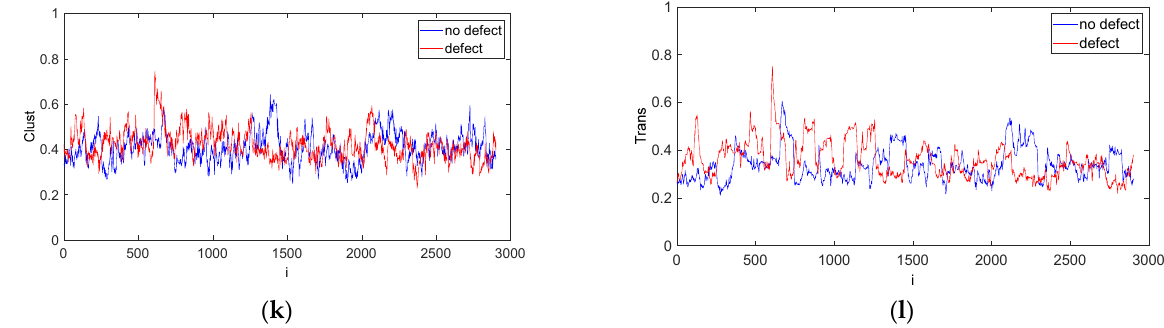
Figure 7. Recurrence quantification time evolution obtained by moving window technique for CFRP without defect (blue line) and with defect (red line): DET ( a ), L ( b ), L MAX ( c ), ENT ( d ), LAM ( e ), TT ( f ), V MAX ( g ), T1 ( h ), T2 ( i ), RTE ( j ), CC ( k ) and Trans ( l ). The calculations were made with w s = 100 and w i = 1. The quantifications show system behaviour over time.